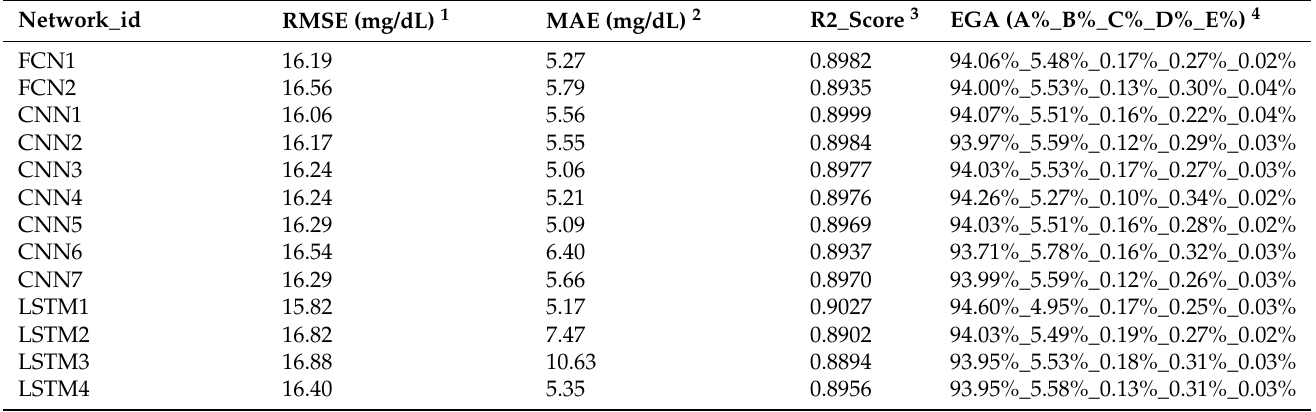
Table 2. The prediction accuracy of 13 deep neural networks.